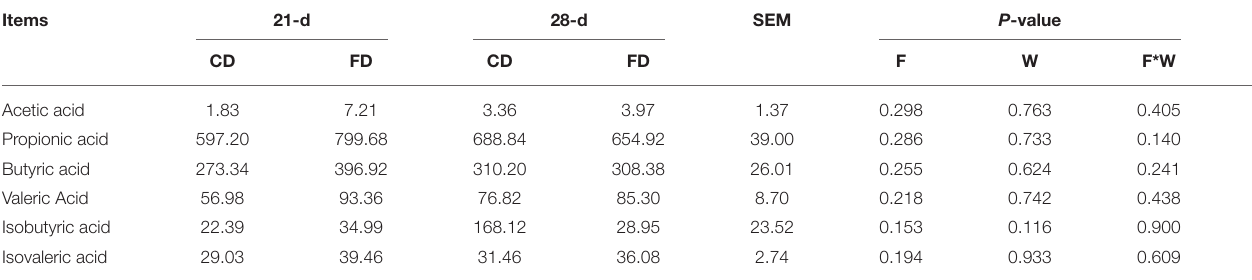
TABLE 5 | The effects of fermented diet and weaning age on the concentrations of short-chain fatty acids in cecal content of piglets (mg/kg). Items 21-d 28-d SEM P -value CD FD CD FD F W F*W Acetic